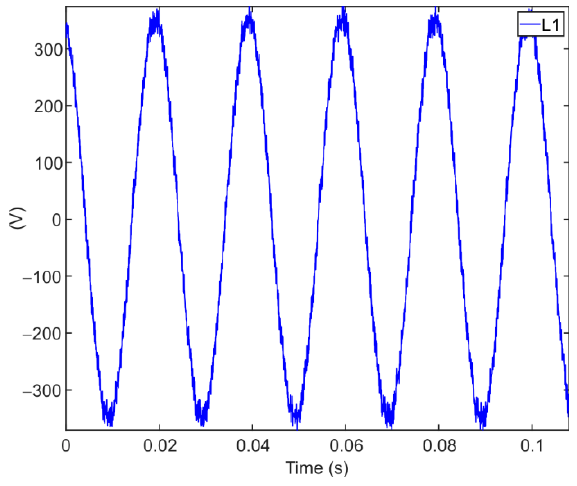
Figure 6. Noise waveform with SNR of 27 dB.